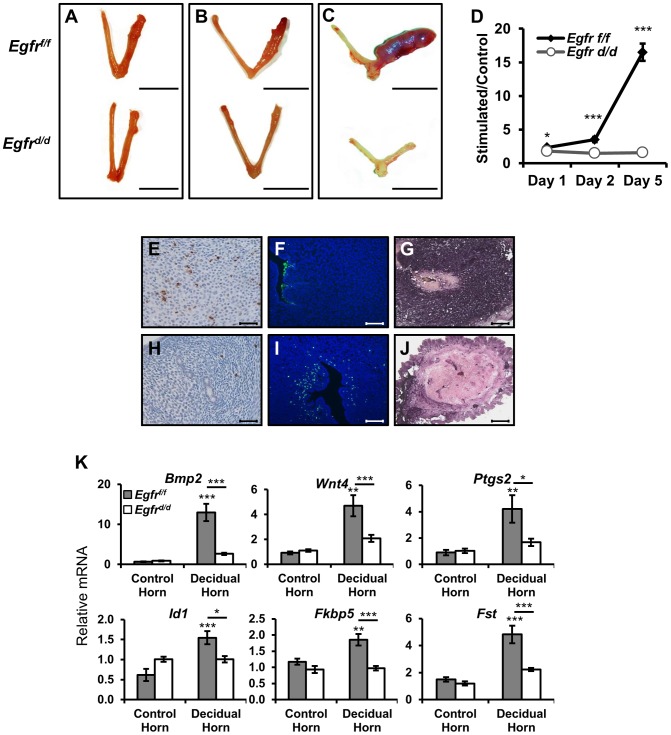

Egfr ablation results in major defects in decidualization.Ovariectomized mice were treated with exogenous hormones and a deciduogenic stimulus was administered to one uterine horn. Gross uterine morphology of uteri (A) 1 day, (B) 2 days, or (C) 5 days after deciduogenic stimulus. Scale bar: 1 cm. (D) Wet weight ratio of stimulated uterine horn relative to unstimulated horn. Histological analysis of day 2 stimulated uterine cross-sections comparing (E–G) Egfrf/f and (H–J) Egfrd/d. (E,H) Proliferative marker phospho-histone H3, (F,I) apoptosis via TUNEL assay, and (G,J) differentiation via alkaline phosphatase staining. Scale bars: 100 µm (E,H,F,I) and 50 µm (G,J). (K) Measurement of the induction of mRNA expression of known decidual regulators on day 1 uteri by quantitative real-time PCR. Average +/− SEM. *-p<0.05; **-p<0.01; ***-p<0.001. n.s. - not significant.